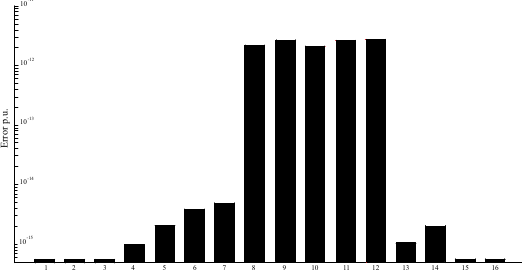
Fig. 1. Voltages error in p.u. for DS16N test system between backward-forward sweep algorithm and EVs-IPP mathematical model